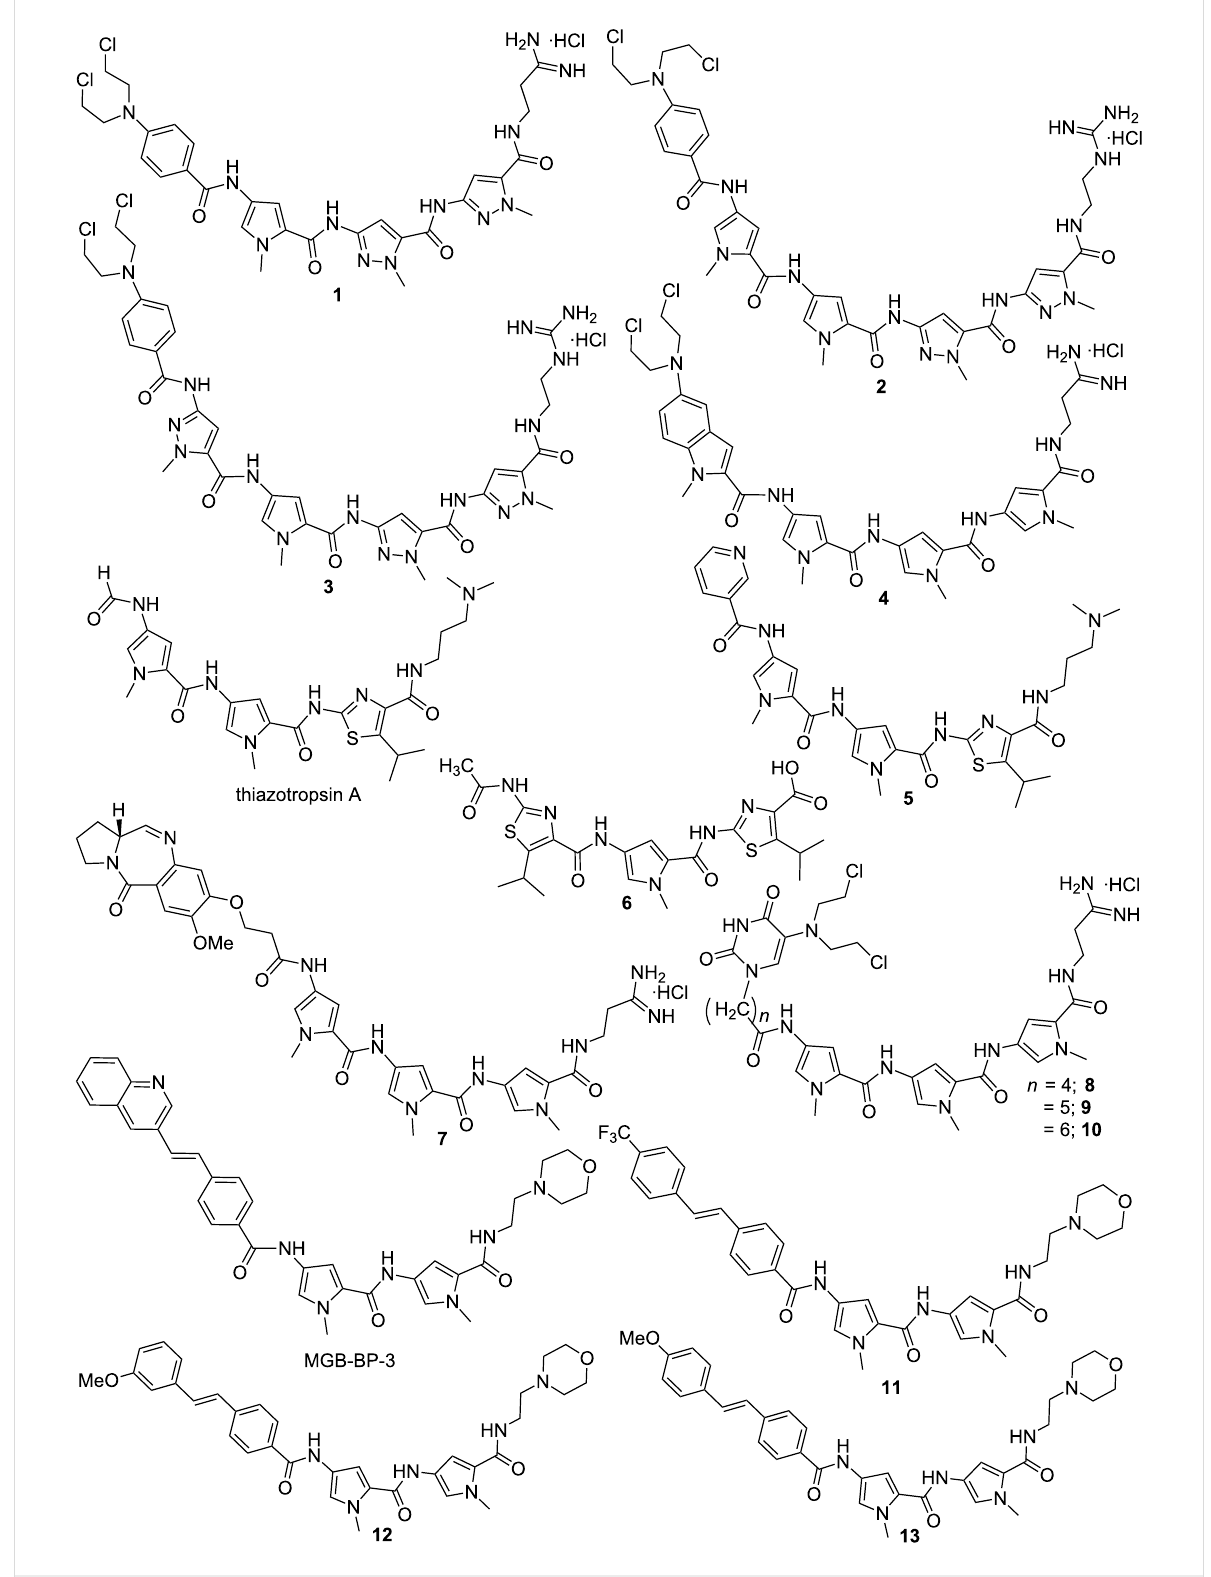
Figure 4: Synthetic structural analogs of distamycin A by replacing one or more pyrrole rings with other heterocycles or by tethering with known anti- tumor